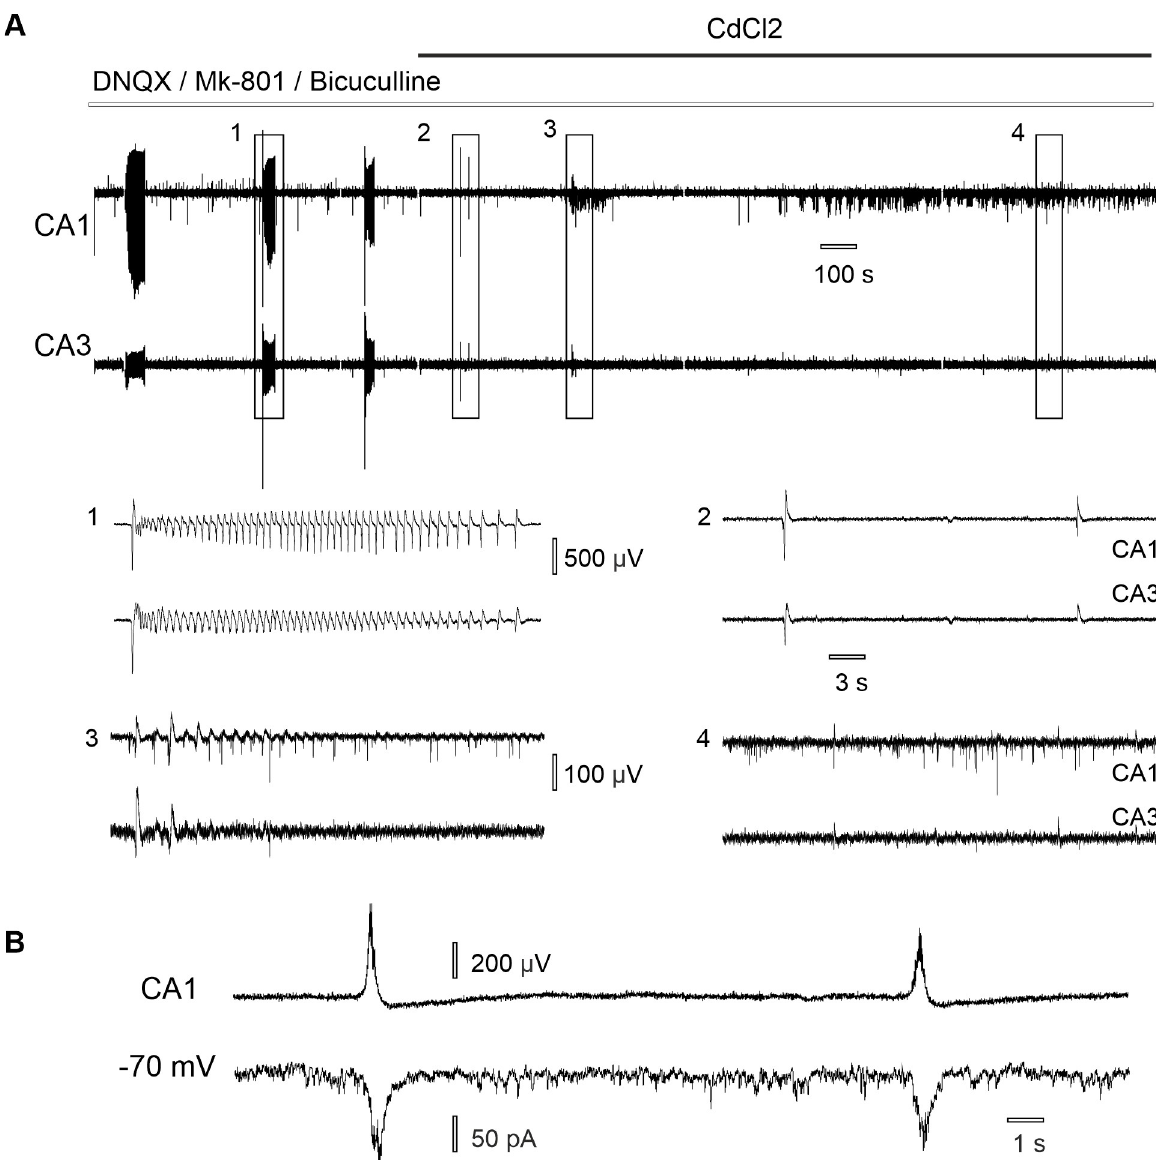
Fig 2. CA3-CA1 synchronization of epileptiform discharges induced in aCSF with AMPA, NMDA, GABA antagonists depends on synaptic connections. (A) Blockade of the synchronous epileptiform discharges following 15 μ M CdCl 2 application: (1) burst of epileptiform discharges and (2) single epileptiform discharges become less synchronized (3) following 15 μ M CdCl 2 application and nonsynaptic population spikes (4) appear in CA1. (B) Simultaneous extracellular (upper trace) and intracellular (bottom trace) recording in CA1 during perfusion with synaptic blockers aCSF reveals synaptic currents appear during epileptiform